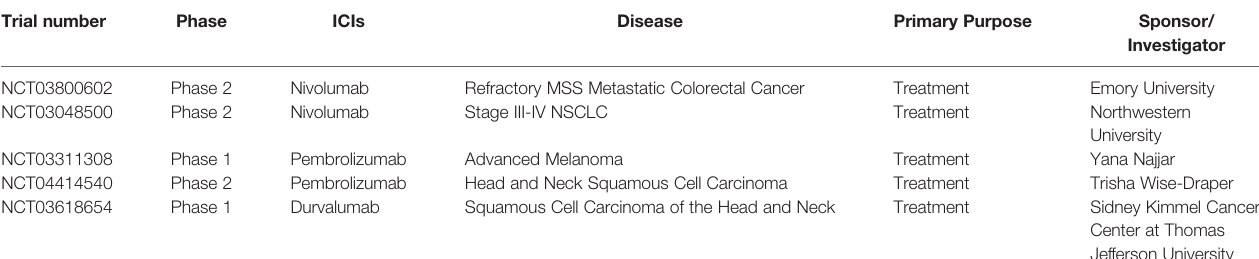
TABLE 2 | Ongoing clinical trials of metformin combined immune checkpoint inhibitors